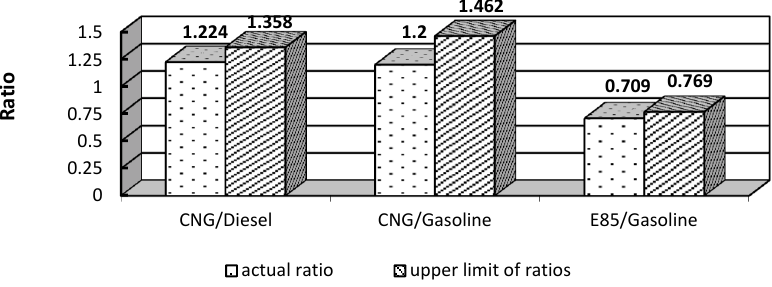
Figure 18. Ratios of Alternative/Conventional fuel prices in Sweden.